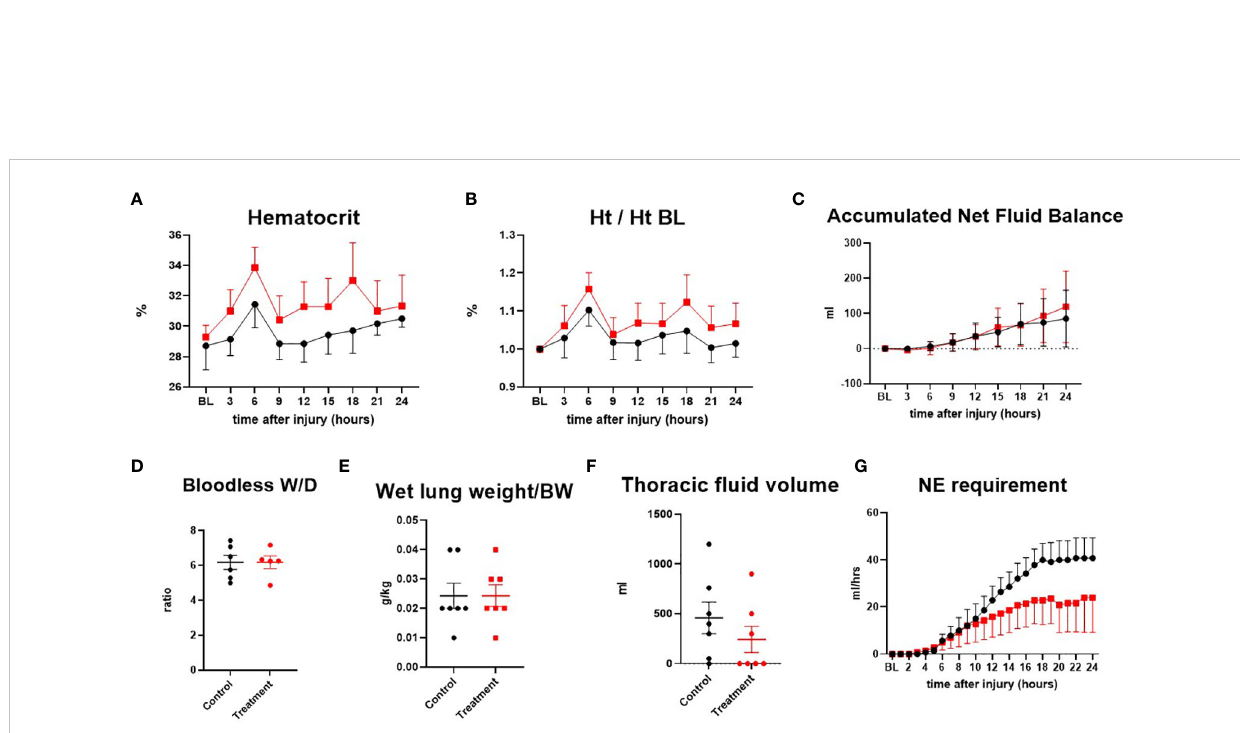
FIGURE 4 The severity of lung injury. ● Control (n=7 at 0-18 h and 6 at 19-24 h), ■ Treatment (n=7 at 0-16 h and 6 at 17-24 h). Hematocrit (Ht) (A) , hematocrit/hematocrit at baseline (Ht/Ht BL) (B) , accumulated net fl uid balance (C) , bloodless wet-to-dry weight ratio (W/D ratio) (D) , wet lung weight/body weight (E) , thoracic fl uid volume (F) , Norepinephrine requirement (G) . Data are expressed as mean ±